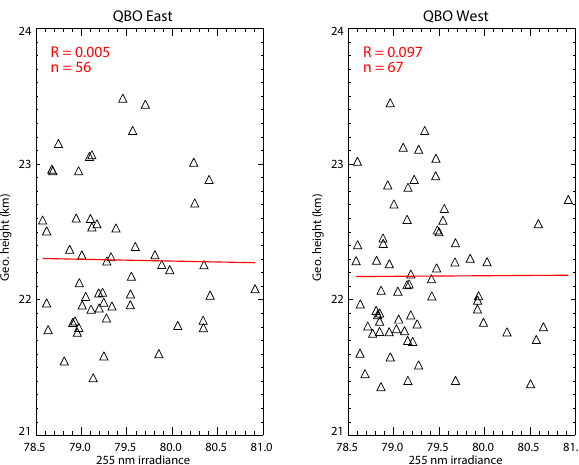
Fig. 5. Scatter diagram of the monthly mean 30hPa geopotential heights (km) at 90 ◦ N in February plotted against the 255nm spec- tral irradiance during QBO east (left) and QBO west (right). Tri- angles represent the individual years over the model simulation (1850–2005) in WACCM4a; n denotes the number of years in QBO east and west, and R is correlation coefficient between the 255nm spectral irradiance (mWm − 2 nm − 1 ) and geopotential heights.